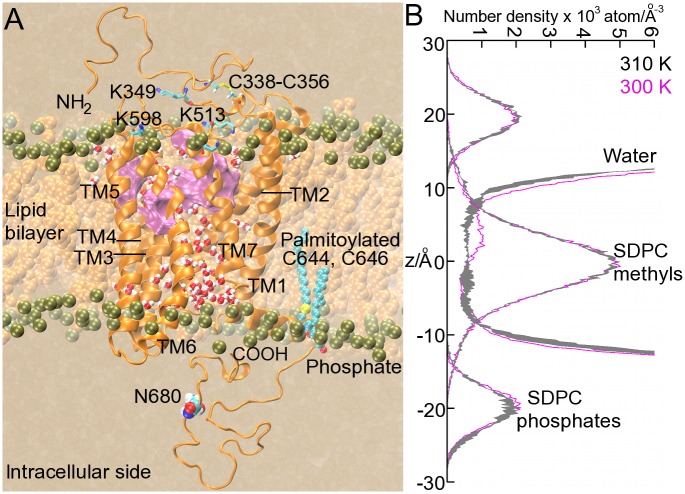
Simulation box including the FSHR and the lipid bilayer.(A). Snapshot at the end of the MD trajectory R0 for the I1 FSHR model. The upper surface in the interhelical region (colored in magenta) corresponds to the putative binding pocket with residues T449, I411, L415, V450, S453, Y530, L537, S589, M585, H615, I588, S589, K608 and V612. The receptor backbone is depicted as orange ribbons; water molecules in the interhelical region are depicted as spheres, with hydrogen in white and oxygen in red; phosphorous atoms are depicted as bronze spheres. In the background, the lipid hydrocarbon tails are depicted as orange spheres. Water is depicted as a continuum solvent in ochre color. (B) Number density across the normal bilayer for water, phosphate and terminal methyl groups, of the lipid heads and tails of the SDPC molecules, respectively. Solid gray lines represent density profiles for the I1 variant at 310 K (line width corresponding to ± standard deviation), and magenta lines at 300 K. The hydrophobic core of the bilayer was defined using the SDPC methyl groups distribution and interfaces using the SDPC phosphate groups distributions. Water molecules in the interhelical region formed a channel communicating the extra- and intracellular sides.